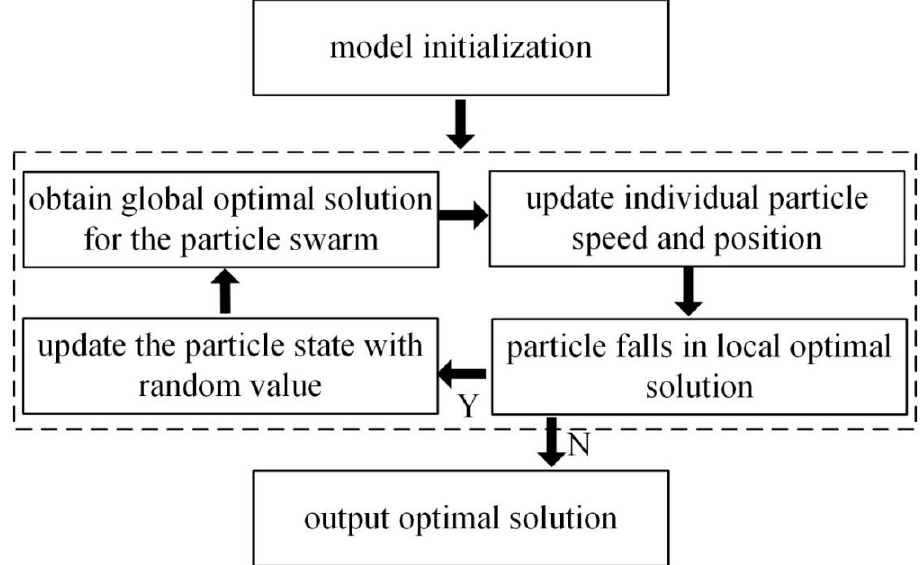
Figure 2. Schematic overview of the proposed EPSO model.